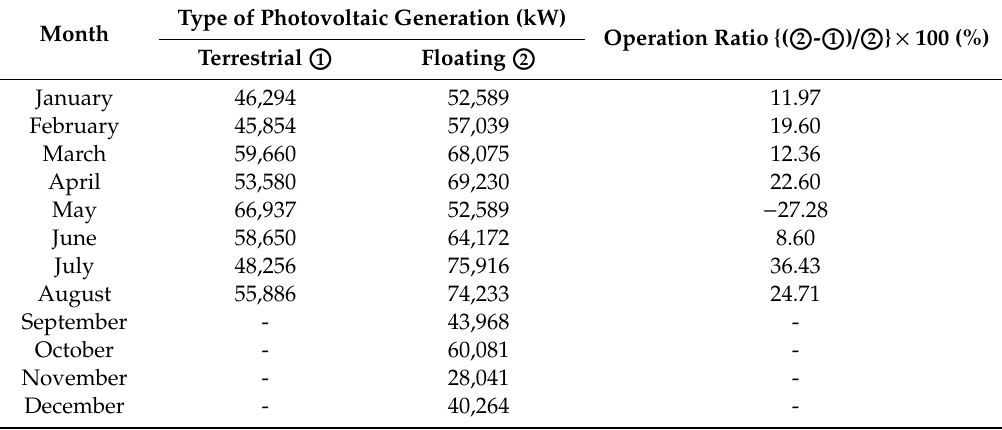
Table 7. Comparison of monthly energy production e ffi